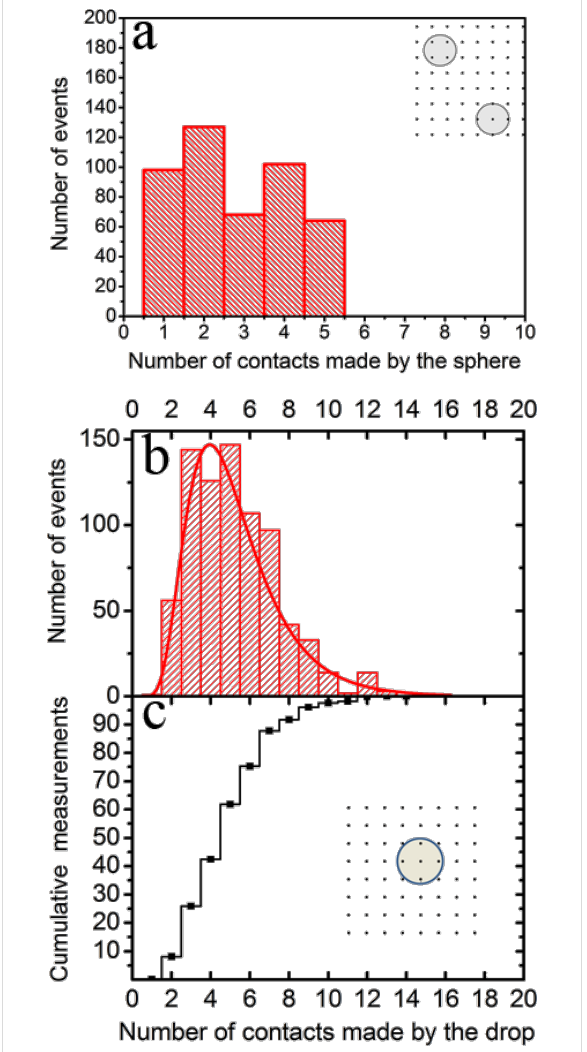
Figure 10: Distribution of the number of contacts with the array of sharp peaks: a) The number of contacts made with the glass sphere is between 1 and 5. b) The number of statistically significant contacts with the mercury drop is between 2 and 9. The red line is a log-normal fit as a guide to the eye. c) Cumulative frequency chart of the number of peaks of the array that interact with the mercury drop (b). The insets in (a) and (b) present sketches of the possible ways in which the lower parts of the sphere or the drop, as observed from above, can interact with the